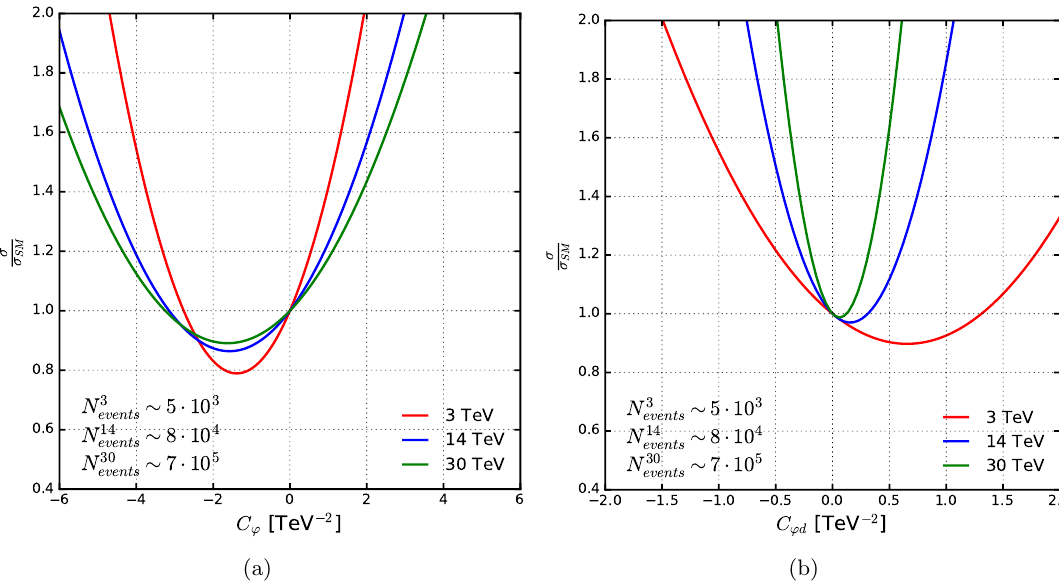
Figure 5 . Sensitivity to Higgs pair production from VBF as a function of the Wilson coe(cid:14)cients p for (a) C ’ and (b) C ’d (right panel) at s = 3 TeV (red), 14 TeV (blue) and 30 TeV